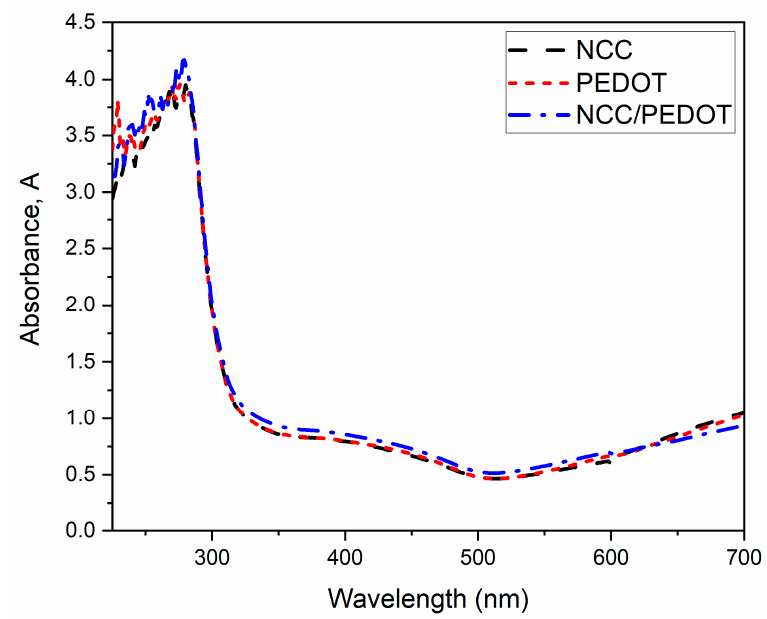
Figure 5. Absorbance spectrum of the NCC, PEDOT, and NCC/PEDOT thin film.